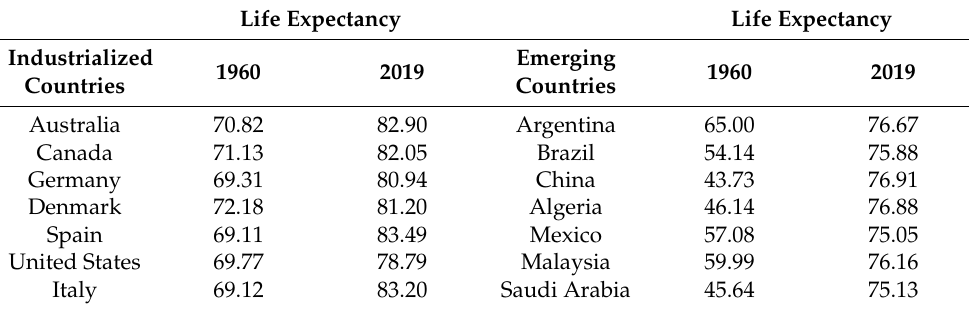
Table 1. Life Expectancy at Birth (World Bank 2022).